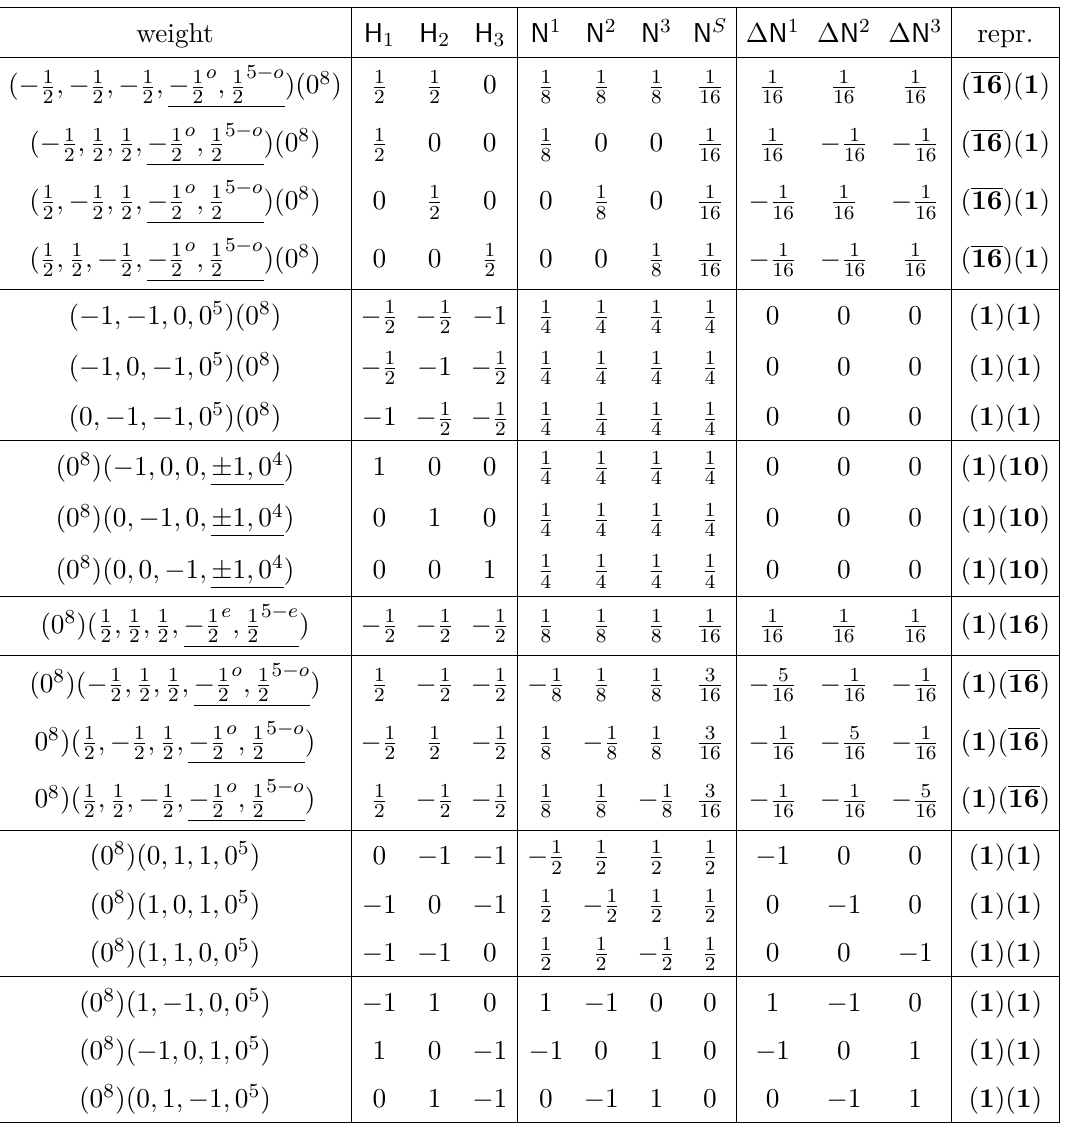
Table 6 . The line bundle charges H i and the triangulation multiplicities N i , N S are given for all the E 8 × E 8 roots charged under the line bundle background defined by (4.14). Note that for this model many of the triangulation difference multiplicities ∆ N i are non-integral signifying that this model is not fully